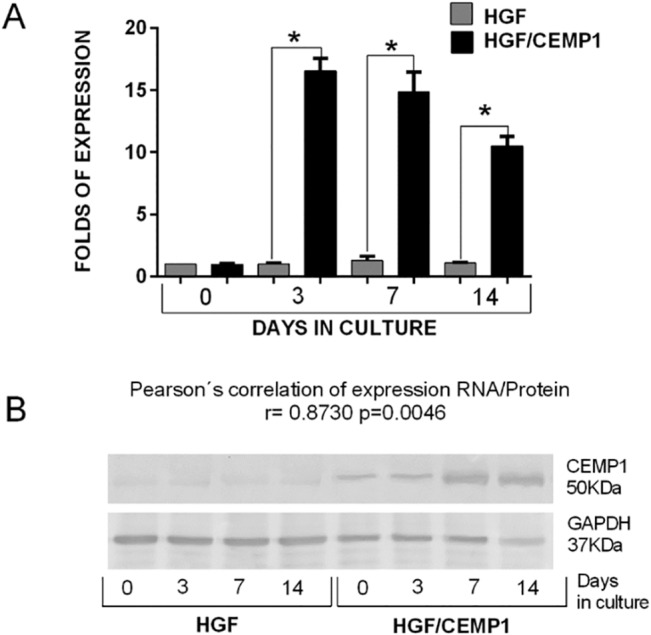
Expression of CEMP1 in HGF/CEMP1.The expression of CEMP1 after transfection in HGF and HGF/CEMP1 was evaluated using quantitative real time PCR at 3, 7 and 14 days. Fold increase of CEMP1 expression are represented, the graph shows that expression was higher in HGF/CEMP1 in all time points. * p = 0.0001 (A). CEMP1 protein expression levels were corroborated by western blot assays (B).